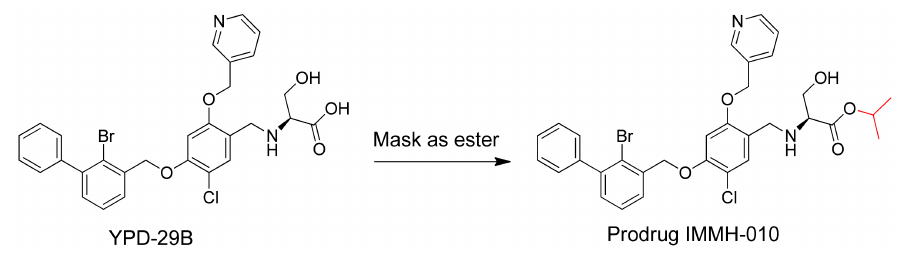
Figure 1. Modification of potent PD-L1 inhibitor YPD-29B to ester prodrug IMMH-010 in order to resolve the undruggable physiochemical